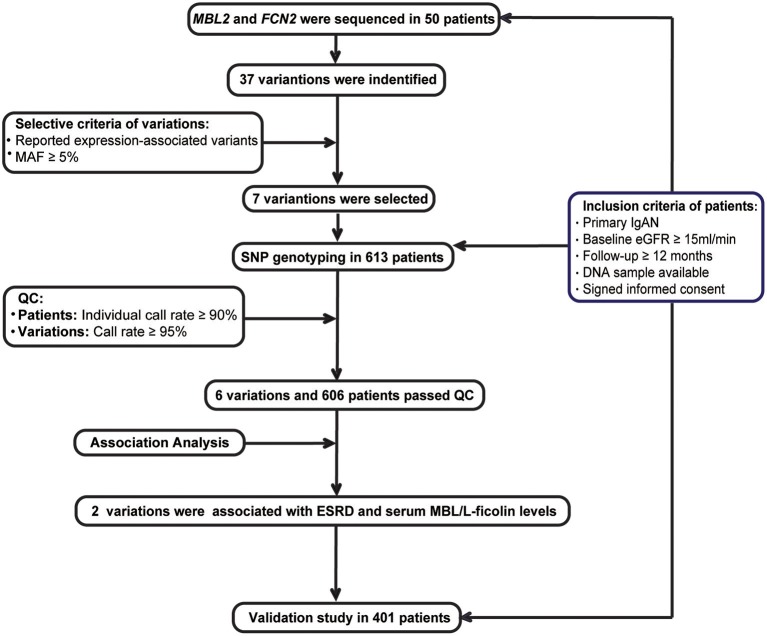
Study flow diagram.